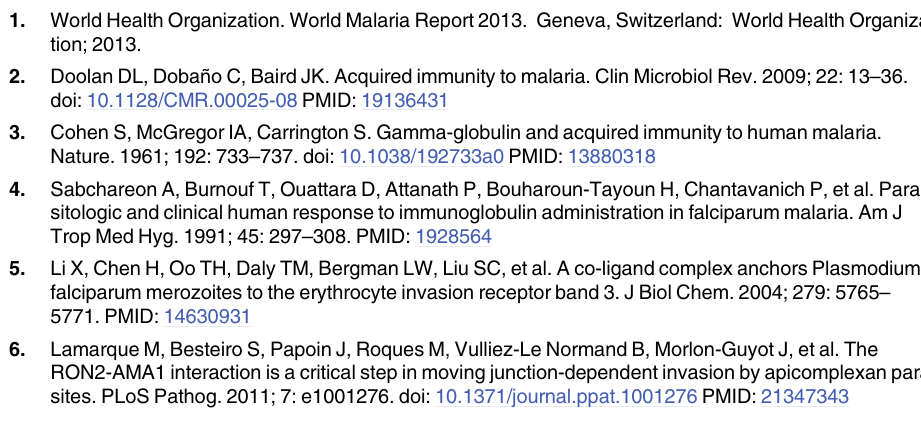
S3 Table. Polymorphism Distribution between the Groups with and without Antibodies against Blood-Stage Proteins of P . vivax . S4 Table. Antibody levels (RI) for PvAMA-1, PvDBP, and PvMSP-1 current infection status, and previous episode of